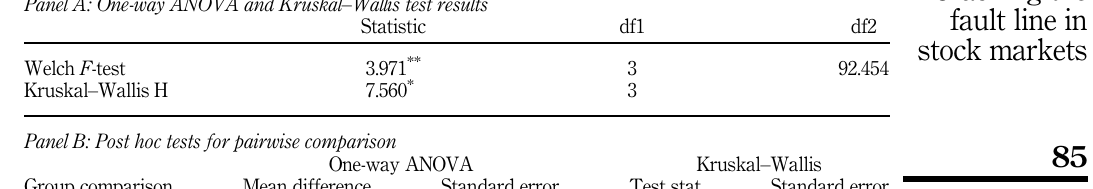
Table 6. Multiple comparisons